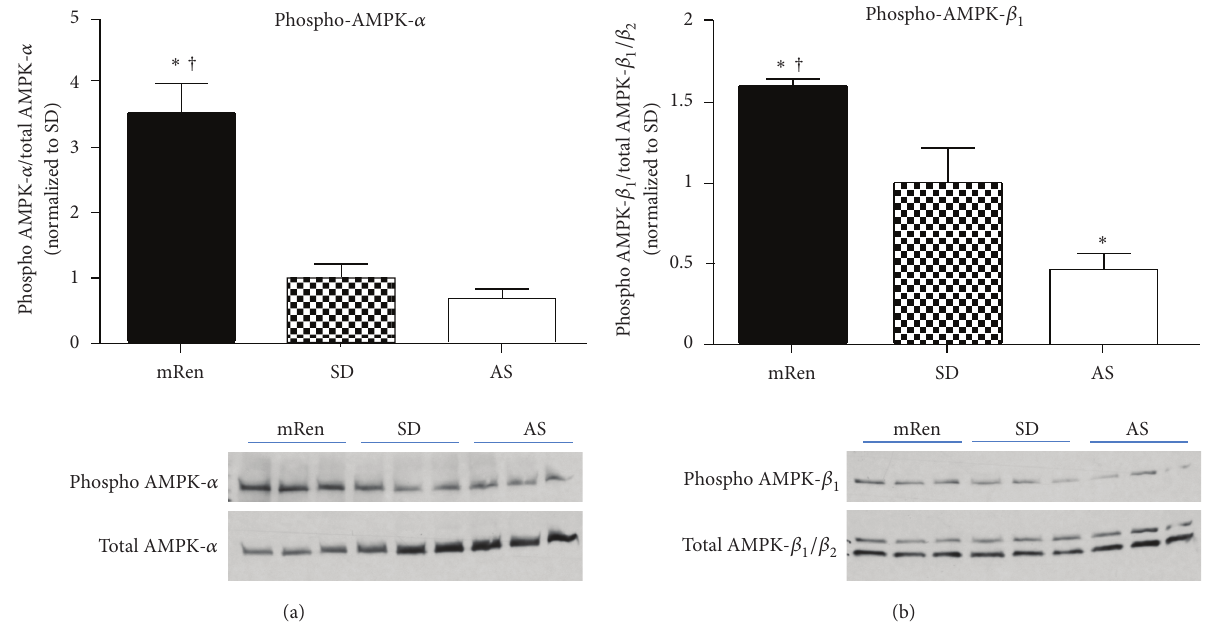
F 4: Hypertensive (mRen2)27 rats show signi�cantly increased phosphorylated AMP-Kinase (AMPK) in the brain dorsal medulla. (b) activities were measured by Western blot hybridization using phospho-speci�c antibodies (Cell Signaling) in AMPK- (a) and brain dorsal medulla tissues from (mRen2)27 [mRen], Sprague-Dawley (SD), and ASrAOGEN (AS) rats. Top: Densitometry analyses of phoshorylated protein levels normalized to total AMPK- 𝛽𝛽 1 versus AS